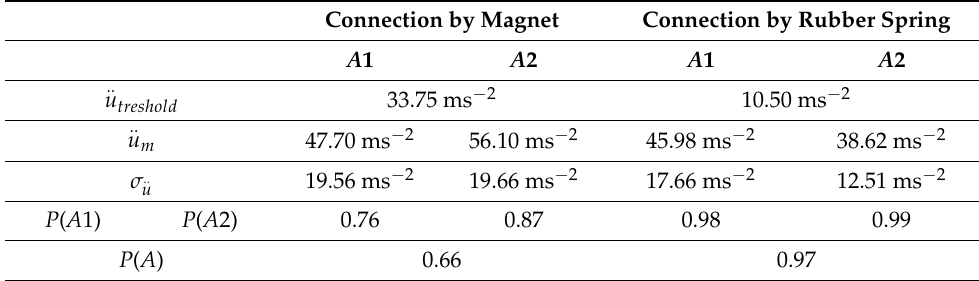
Table 5. Reliability of guiding profile damage